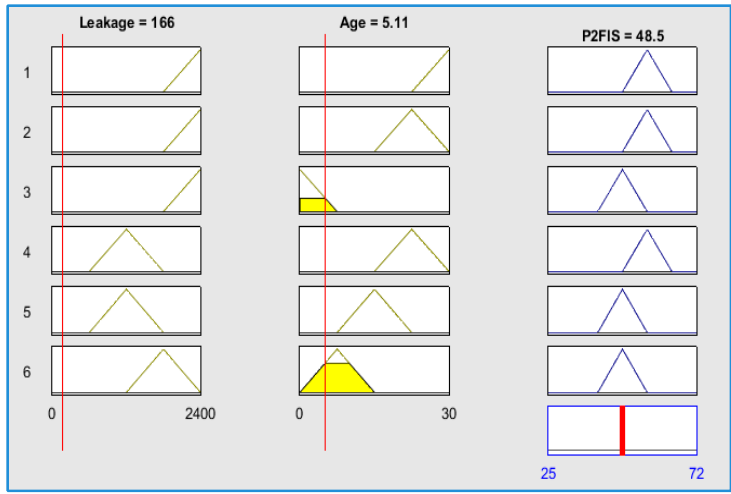
Figure 13. Example of fuzzy rules used in P 2 _FIS.